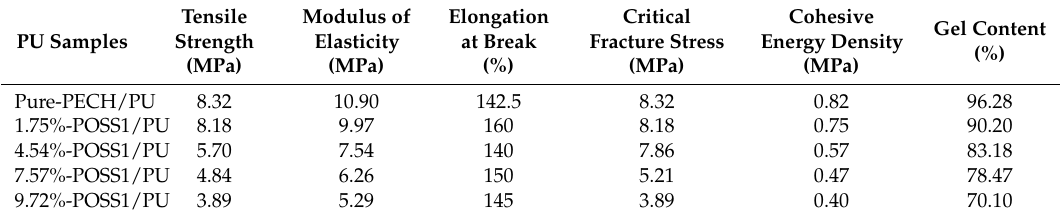
Mechanical properties and gel content of polyurethane polymers with different POSS–PECH contents.